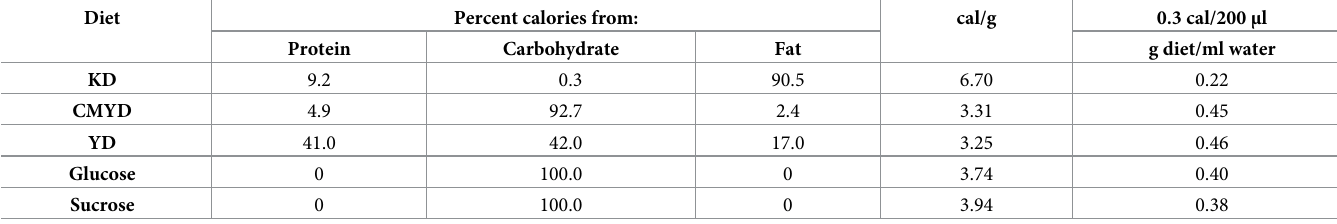
Table 1. Caloric content of diets used in Figs